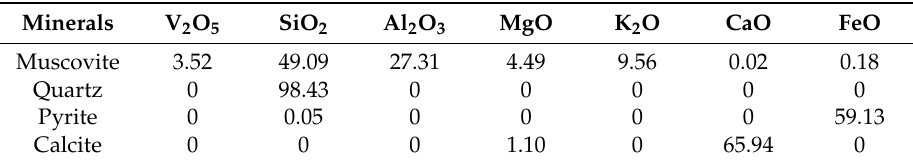
Figure 2. XRD pattern of raw vanadium-bearing shale ore. Table 2. EPMA result of raw vanadium-bearing shale ore wt %.